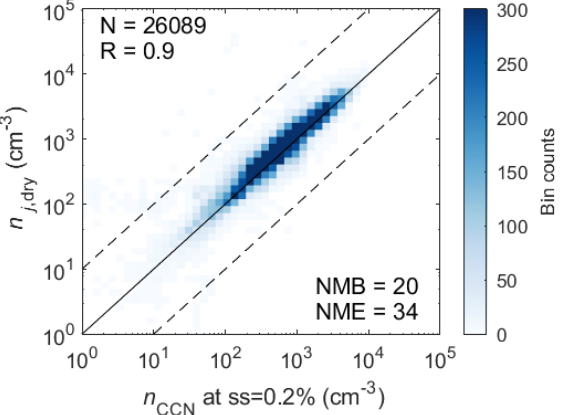
Figure 2. Comparison of concurrent in situ measurements of hourly n CCN at 0.2% supersaturation and n j ,dry ( j = 100 nm for dust influenced Finokalia station and j = 50 nm for other sites). The values of correlation coefficient (R), total number of bins (N), normalized mean bias (NMB) and normalized mean error (NME) are given in the legend.